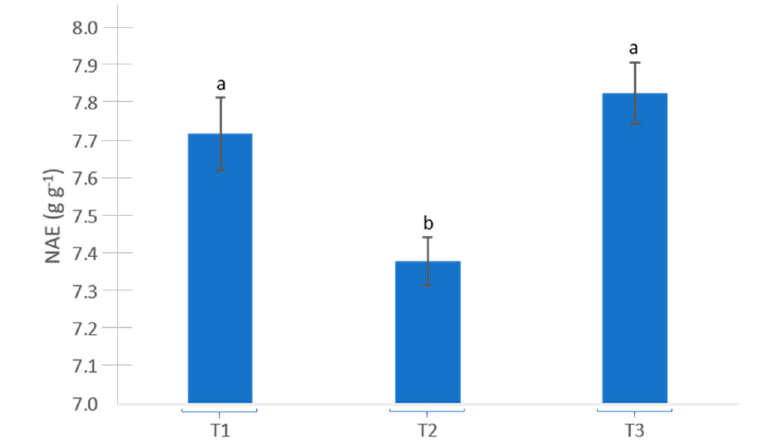
Figure 2. Comparison of nitrogen efficiency in the three fertilized theses. T1 = fertilized pot with commercial NPK fertilizer (Osmocote Topdress); T2 = fertilized pot with LWA based on spent coffee ground, glass and N fertilizer; T3 = fertilized pot with LWA based on spent coffee grounds + biochar, glass and N fertilizers; NAE = nitrogen efficiency; bars indicate standard deviations. Means followed by the same letter do not significantly differ at p < 0.05.